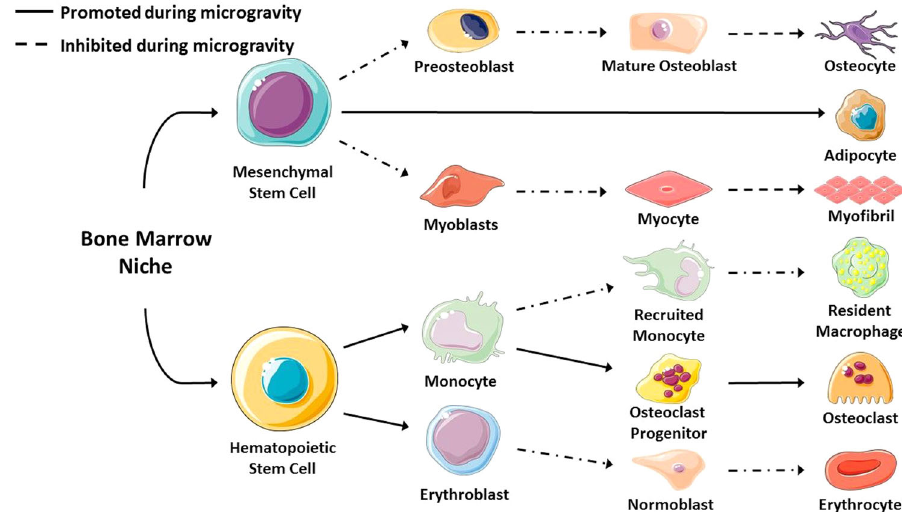
Fig. 2 Schematic illustrating the effect of microgravity on the differentiation of stem cells into various cell lineages. Microgravity increases commitment to the adipogenic and osteoclastic lineage while decreasing commitment to the osteoblastic, myocytic, erythrocytic, and macrophage lineages. Created using images modi fi ed from Servier Medical Art by